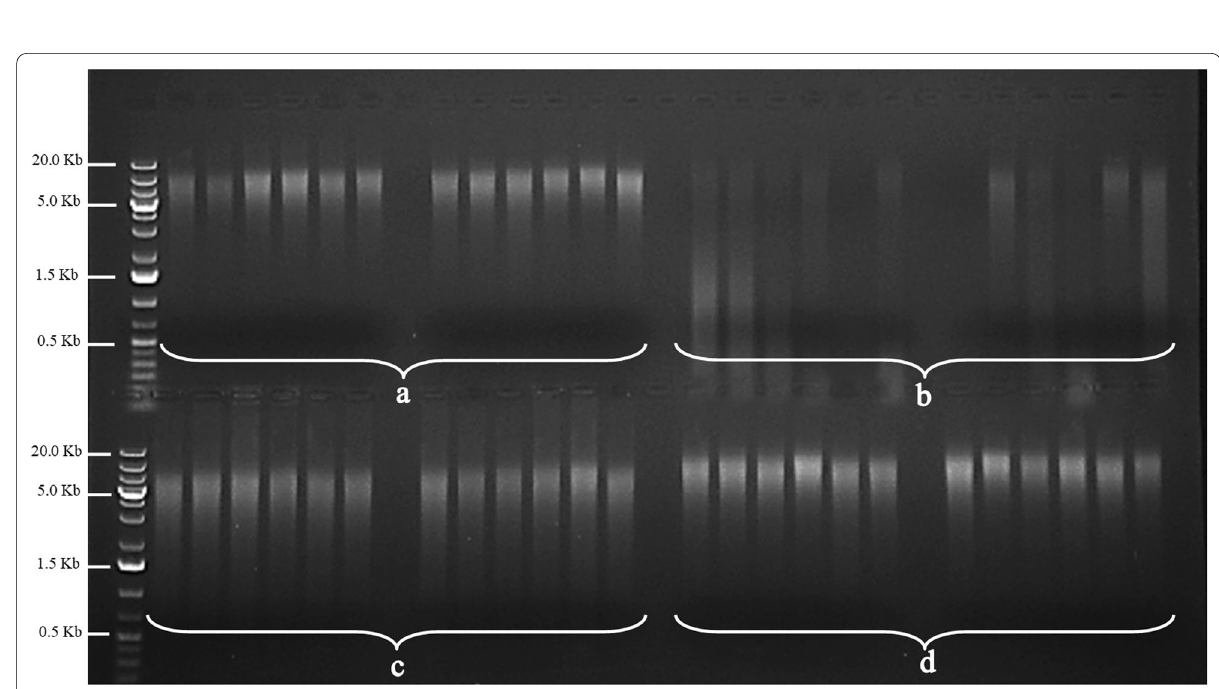
Values (predicted mean (SED)) in the same row with different letter superscripts denote groups with statistically significant means based on the F -test ( p < 0.05) computed using the predictmeans R package 1 NanoDrop: µg/g of dry weight rumen content 2